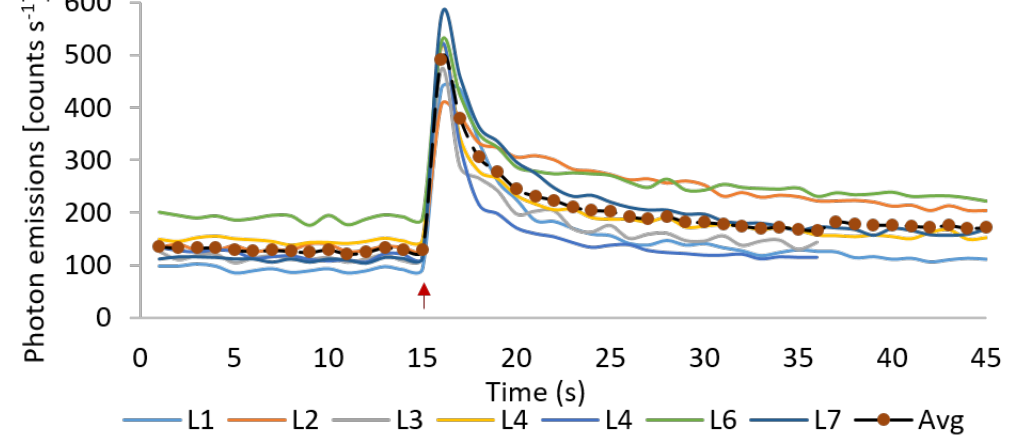
Figure 4. Mechanical injury-induced ultra-weak photon emission measured using visible PMT from seven different leaves (L1–L7) of Arabidopsis. Each plot is the average of f_avg TE values from no-filter slots 1, 5, and 9. Y-axis represents these average photon emission expressed as counts s − 1 . The X-axis represents time unit (34 s), which is the time gap between two consecutive no-filter (TE) measurements. Measurement was started ~20 s after mechanical injury indicated by the red arrow.